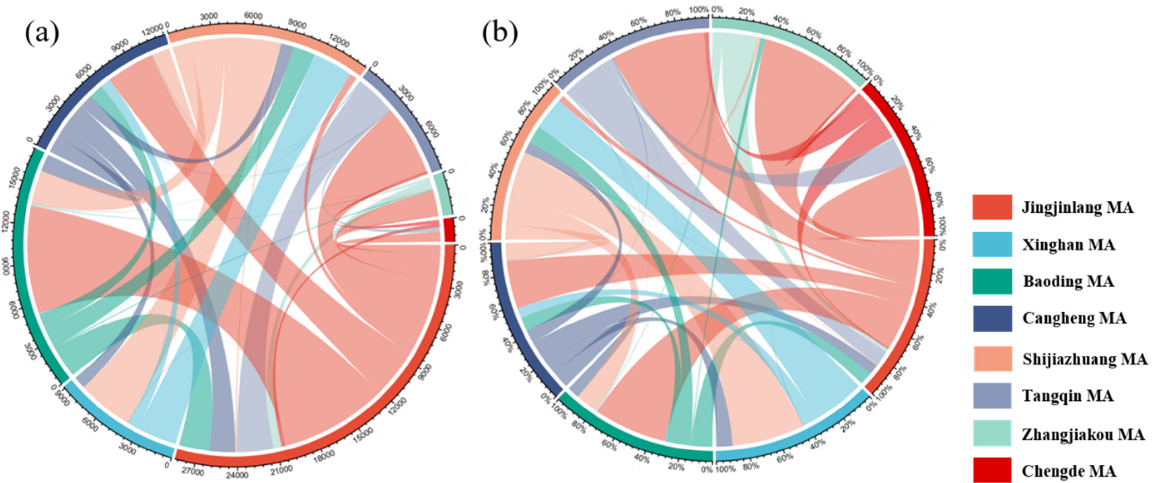
Figure 10. Linkages between metropolitan areas: ( a ) Strength of the linkages between metropolitan areas; ( b ) percentage of links between metropolitan areas. (The diagram’s colors represent the various metropolitan areas, and the thickness of the lines represents the strength of the linkage flows.)